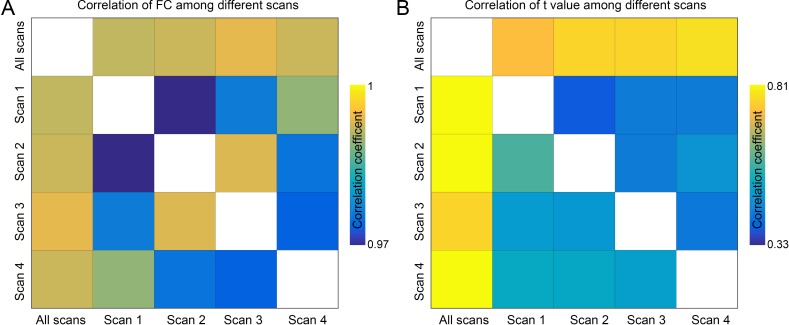
The correlation between four scans.(A) The correlation of the strength of the whole brain functional connectivity between four scans. All the correlations between the different scans are larger than 0.98, which means that the whole brain functional connectivity pattern is very robust among the four sessions, even though these acquisitions have different phase encodings (LR and RL). (B) Comparison of whole brain functional connectivity difference pattern between the four scans. The lower triangle matrix shows the correlation of t values of the whole brain links based on the four scans in the smoking group. The upper triangle matrix shows the correlation of t values of the whole brain links based on the four scans in the drinking group.